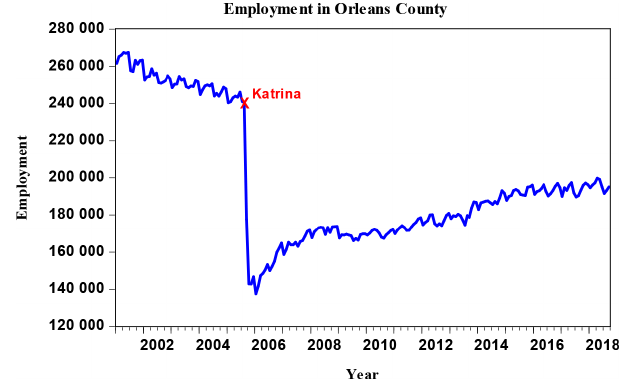
Figure 1. Monthly employment time series in Orleans County be- fore and after Hurricane Katrina.